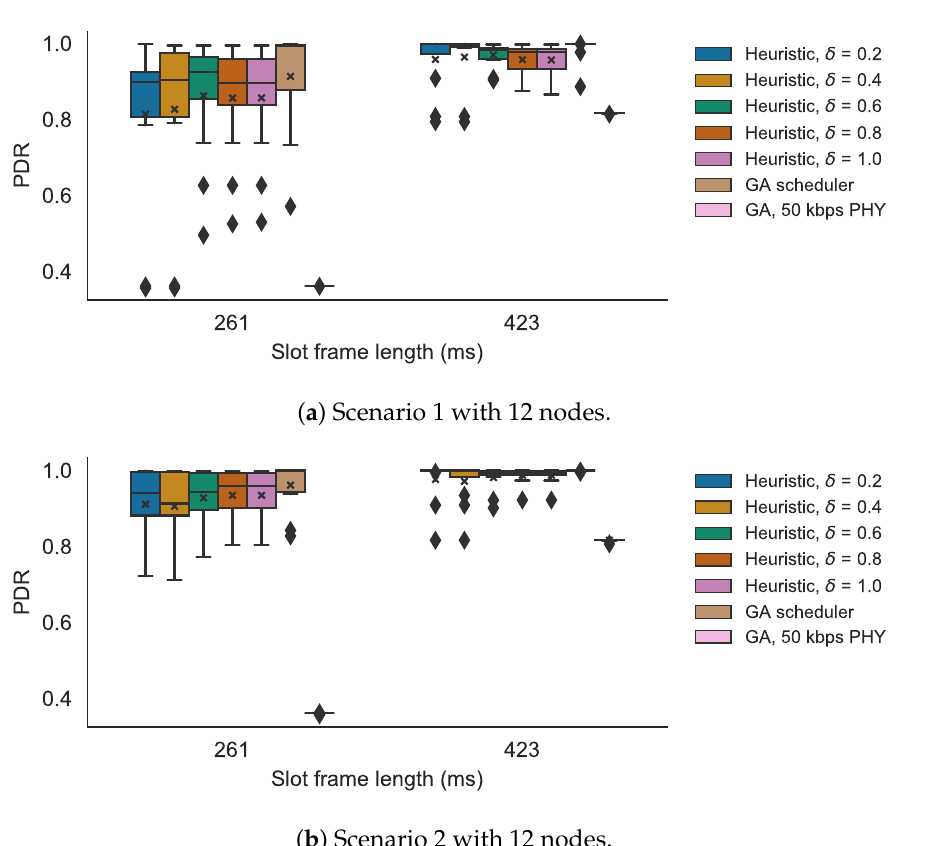
Figure 11. PDR values for different δ values for 261ms and 423ms slotframe lengths, comparing the heuristic with the GA scheduler and the GA scheduler that can only use the 50kbps PHY. The x denotes the mean value. The diamond shapes represent outliers that are values smaller than the minimum (i.e., the lower whisker), or larger than the maximum, value (i.e., the top whisker).